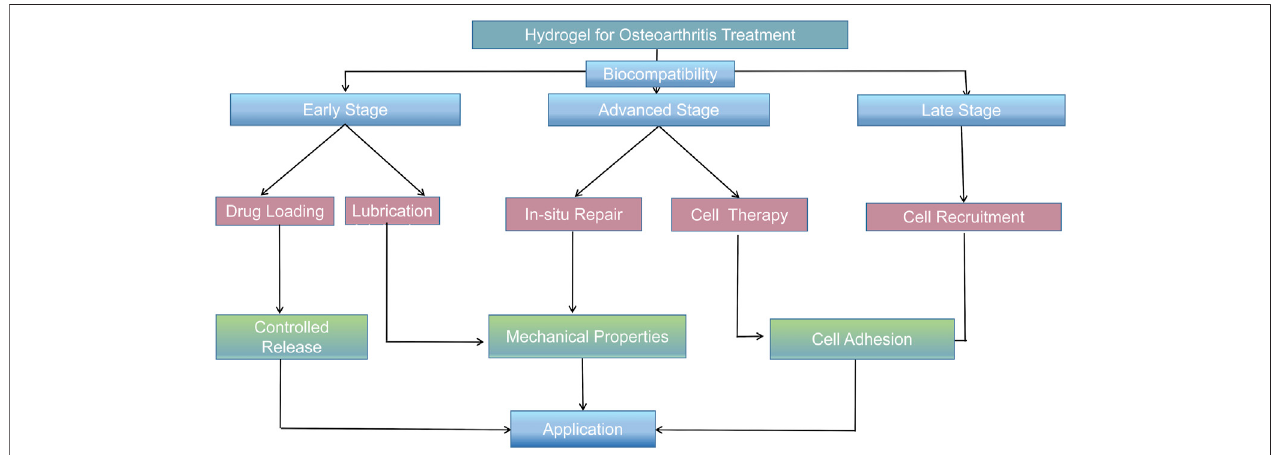
FIGURE 6 | Hydrogel logic diagrams designed for different types of